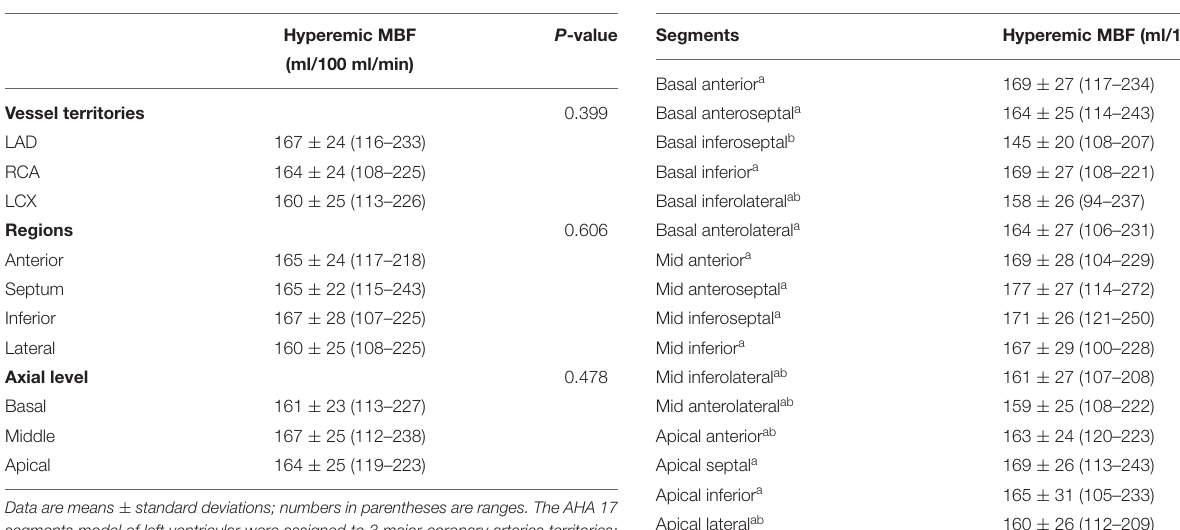
TABLE 2 | Regional distribution of hyperemic MBF. TABLE 3 | Hyperemic MBF of 17